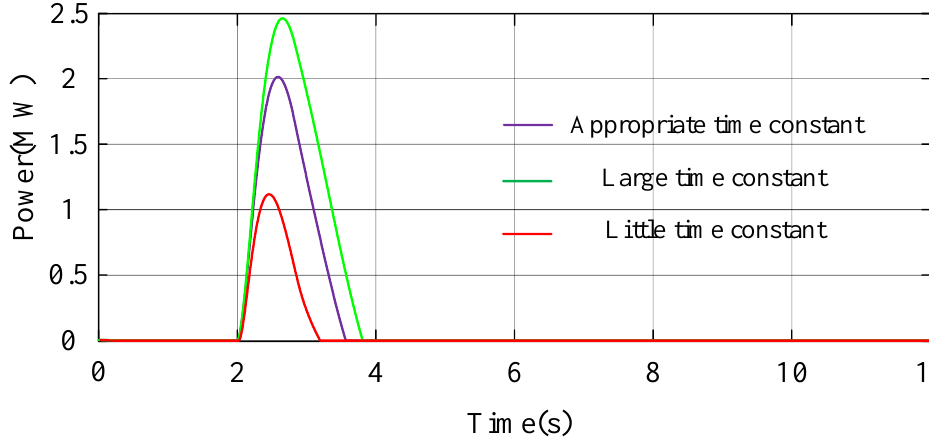
Figure 14. Operation curve of SCESS with different time constants of the delay link. As shown in Figure 12, when the proposed control strategy was adopted and different time constants were used in the delay link, the system frequency deviation was 0.32 Hz; however, when the time constant was suitable, too small and too large, the times for the system frequency to recover to reasonable intervals was different, which were 6.39 s, 6.575 s and 6.68 s respectively. As shown in Figures 13 and 14, with the different time constants that led the P2H device and the SCESS device to their power allocation, the appropriate time constant could cause the P2H load shedding response to have a long time-scale frequency regulation and the SCESS to rapidly release energy in response to a short time-scale of frequency regulation, while the system could achieve a better frequency regulation combined with the power output characteristics of both. constant to simulate and analyze the system frequency regulation results under different wind speed states, while also considering the aggregation effect of wind power